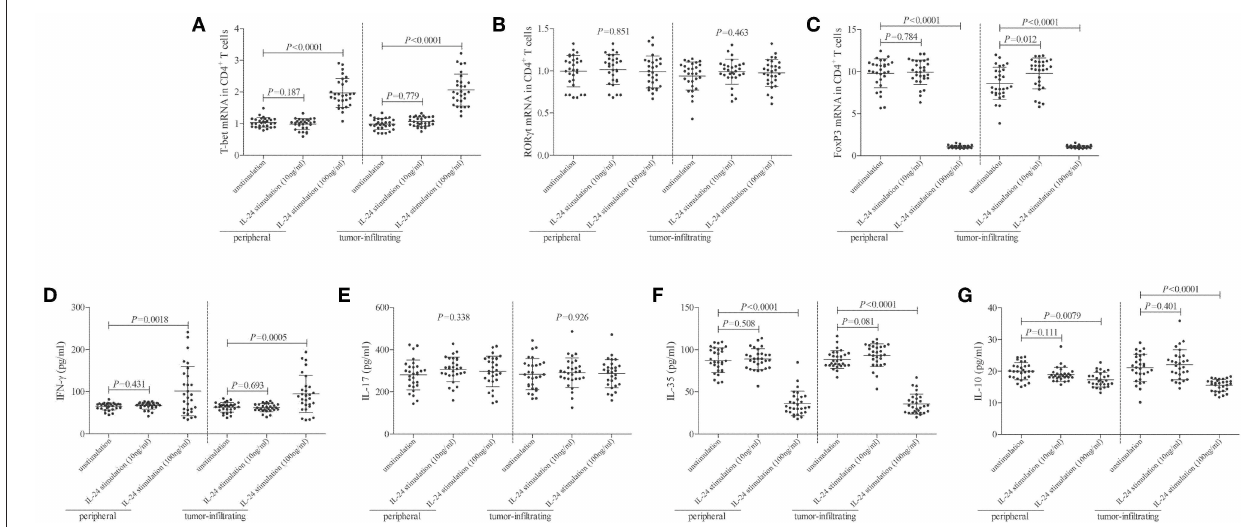
FIGURE 4 | Influence of recombinant IL-24 stimulation on transcriptional factor and cytokine production of peripheral and tumor-infiltrating CD4 + T cells in colorectal adenocarcinoma. 10 5 of purified CD4 + T cells from colorectal adenocarcinoma patients ( n = 29) were stimulated with low concentration (10ng/ml) or high concentration (100ng/ml) of recombinant human IL-24 for 24h. mRNA expression of transcriptional factors, including (A) T-bet (One-way ANOVA, P < 0.0001), (B) ROR- γ t (One-way ANOVA, P > 0.05), and (C) FoxP3 (One-way ANOVA, P < 0.0001), were semi-quantified by real-time PCR, and were compared among groups. Expression of cytokines in cultured supernatants, including (D) IFN- γ (Kruskal-Wallis test, P < 0.05), (E) IL-17 (One-way ANOVA, P > 0.05), (F) IL-35 (One-way ANOVA, P < 0.0001), and (G) IL-10 (One-way ANOVA, P < 0.001), was measured by ELISA, and were compared among groups. Individual level of each subject was shown. One-way ANOVA, Tukey test for multiple comparison, Kruskal-Wallis test, Dunn’s multiple comparison test was used for comparison.